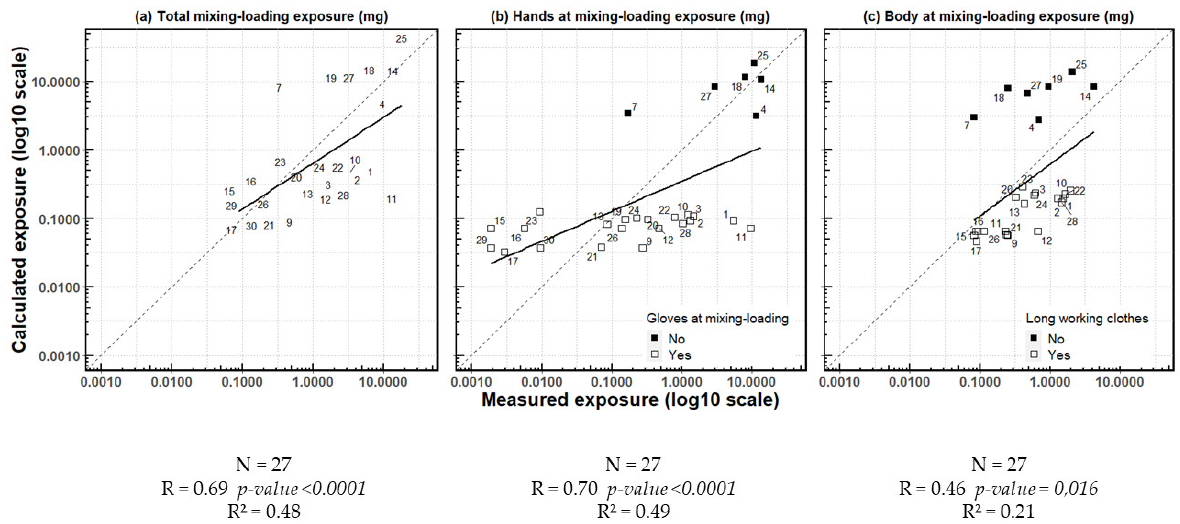
Figure 4. Linear regression of exposure calculated using the AOEM and exposure measured in the CANEPA study during mixing/loading and according to body parts.